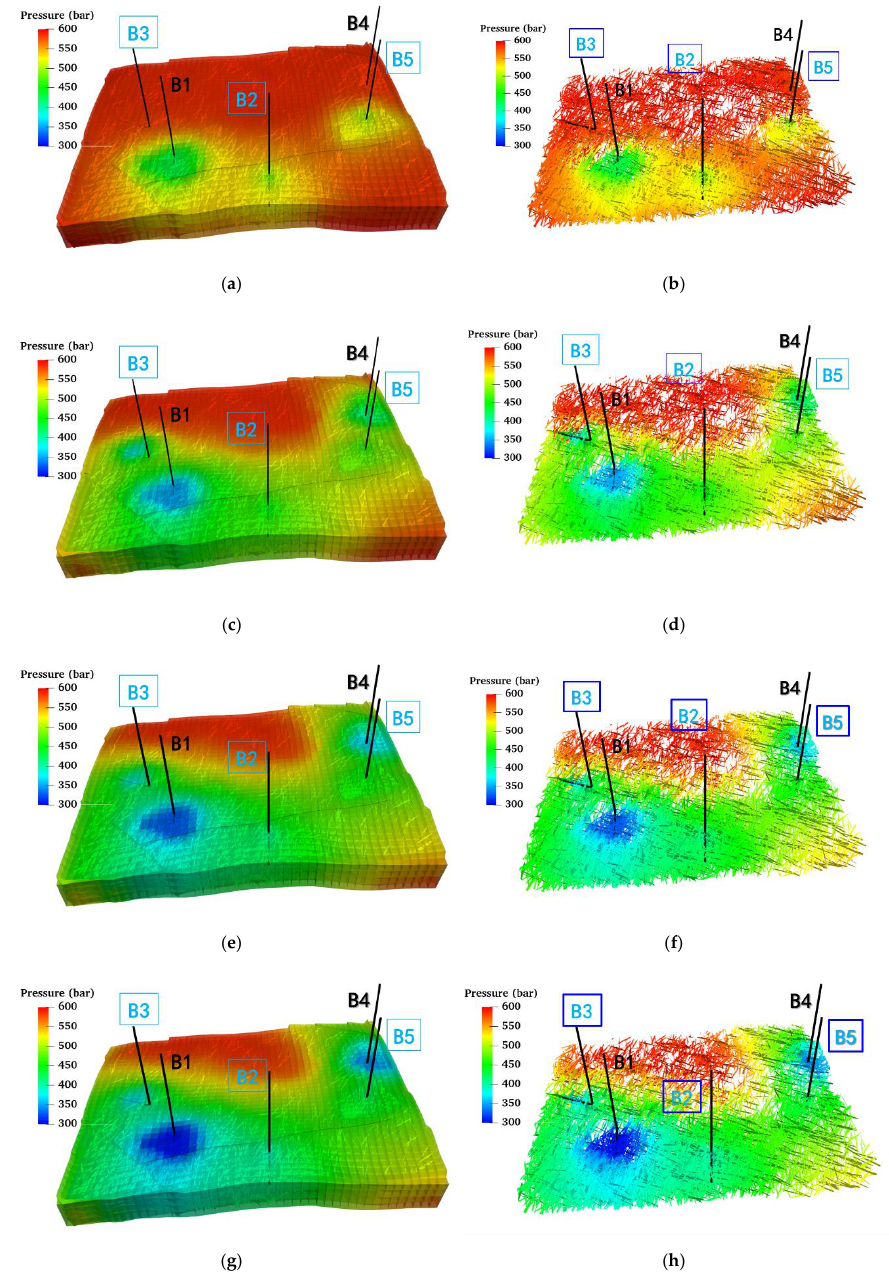
Figure 37. Detailed visualizations of reservoir pressure distributions in both matrix and fractures (left column) and only fractures (right columns) with five wells, more than 10,000 EDFM-fractures: ( a ) matrix and fractures after 270 days; ( b ) only fractures after 270 days; ( c ) matrix and fractures after